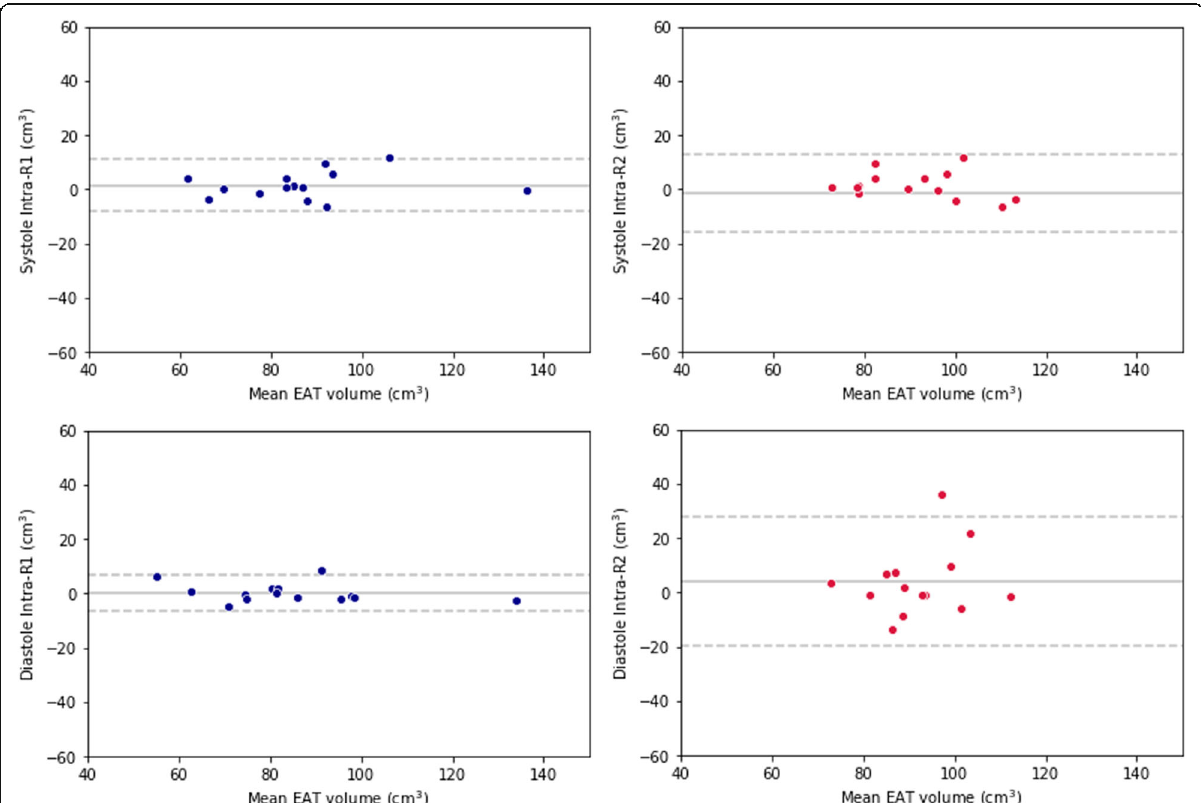
Fig. 2 Bland-Altman plots for intra-reader reproducibility of epicardial adipose tissue volume at systole and diastole for the two readers. Dashed lines represent 95% confidence intervals and are placed at ± 2 standard deviations. EAT, Epicardial adipose tissue; R1, Reader 1; R2, Reader